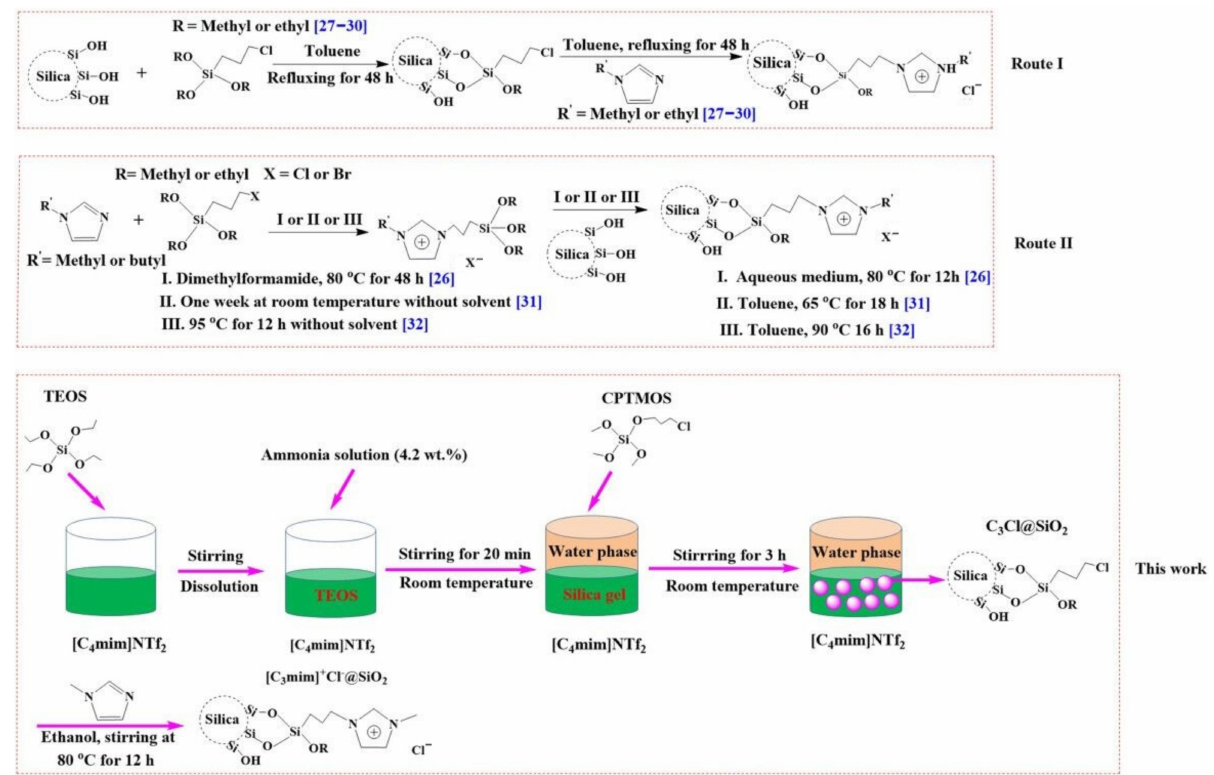
Figure 2. Schematic diagrams of the preparation of ILs grafted silica by reported routes and the proposed